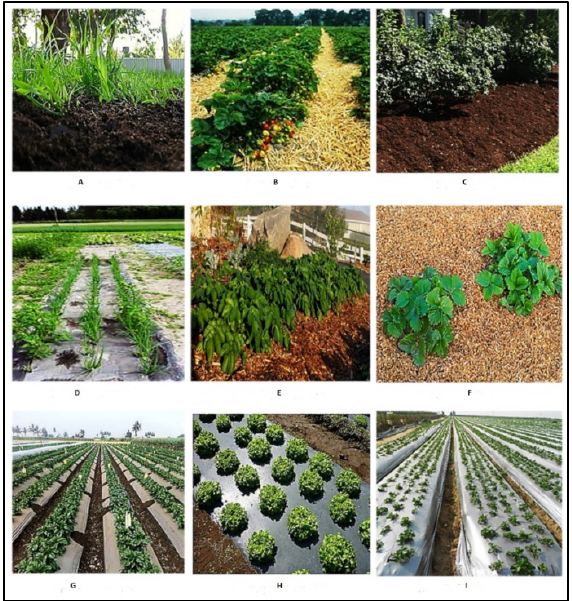
Figure 4. Application of different mulch films in the field—( A ): Compost, ( B ): Straw, ( C ): Bark, ( D ): Newspaper, ( E ): Woodchips, ( F ): Sawdust, ( G ): Plastic, ( H ): Black plastic, ( I ): LDPE. Adapted from